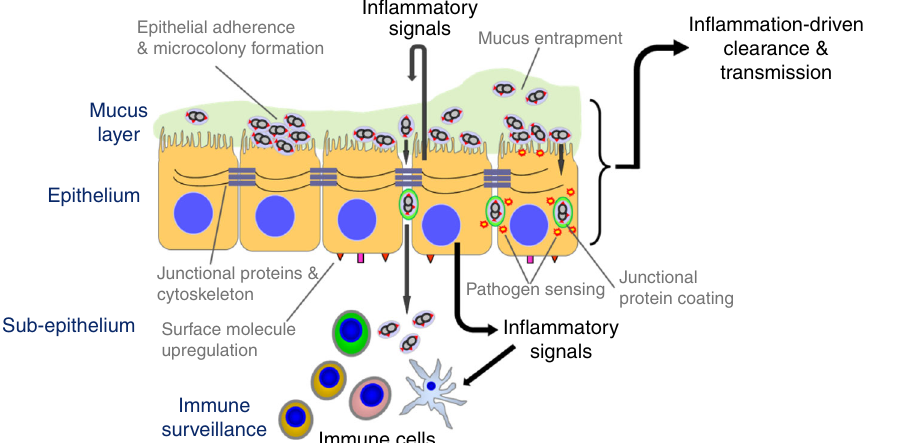
Fig. 8 Model of pneumococcal colonisation at the human mucosal epithelium. Pneumococcal adhesion and micro-colony formation on the epithelial surface may lead to micro-invasion; internalisation of the bacteria and/or transmigration across the epithelial barrier (micro-invasion). The epithelial-derived response is dependent on the subsequent pattern of interactions. Micro-invasion ampli fi es epithelial sensing and in fl ammation/innate immunity, which we postulate leads to immune cell engagement. This process of epithelial sensing in fl ammation/innate immunity may enhance both clearance and transmission. Co-association with junctional proteins may facilitate migration across the